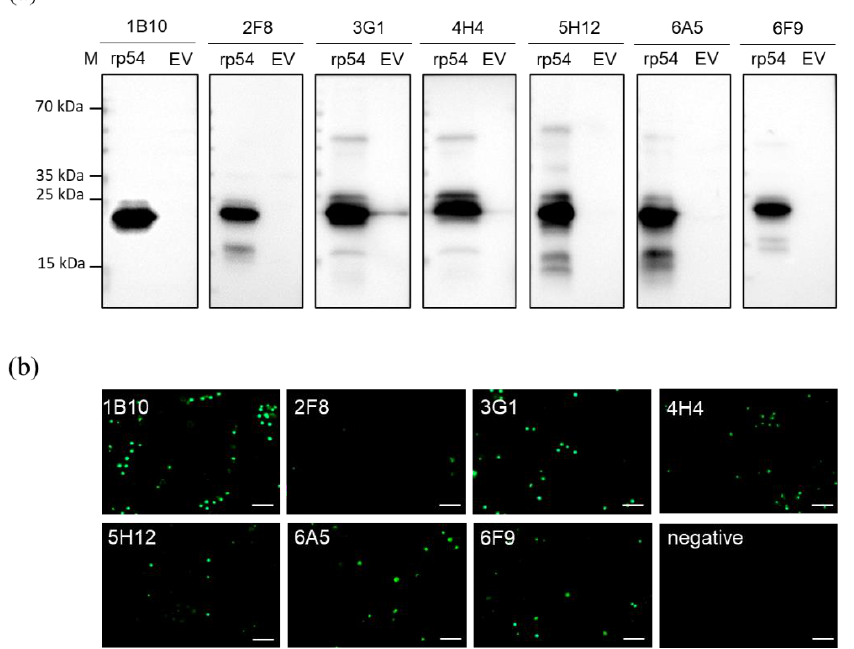
Figure 3. The reactivity of monoclonal antibodies. ( a ). Western blot analysis of anti-rp54 antibodies. The seven anti-rp54 monoclonal antibodies specifically reacted with recombinant protein at 20 kDa. ( b ). IFA performed on ASFV-infected PAMs. Cells were incubated with rp54-specific mAbs annotated on the top left of each panel and stained with Coralite488-conjugated Affinipure Goat Anti-Mouse IgG(H+L). Scale bars, 20 μm.